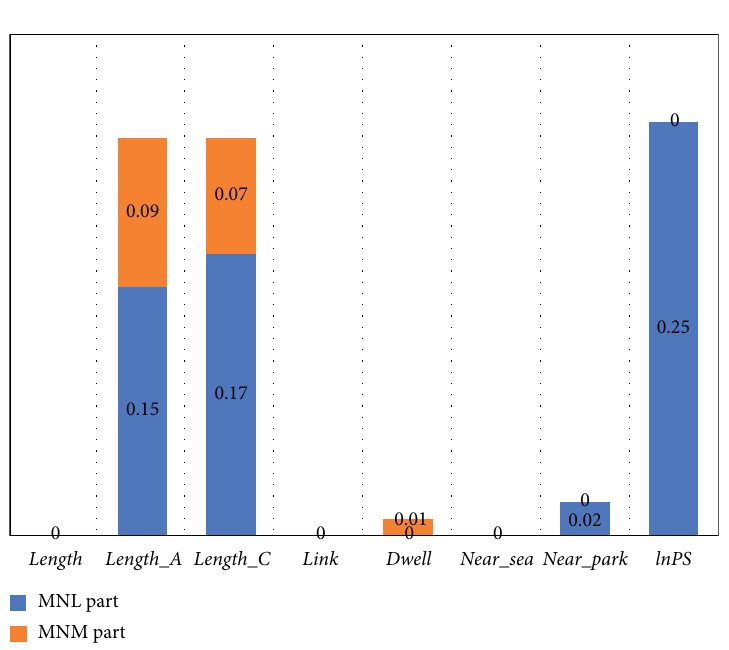
Figure 13: Average power coe ffi cient of each independent variable with both MNL part and MNM